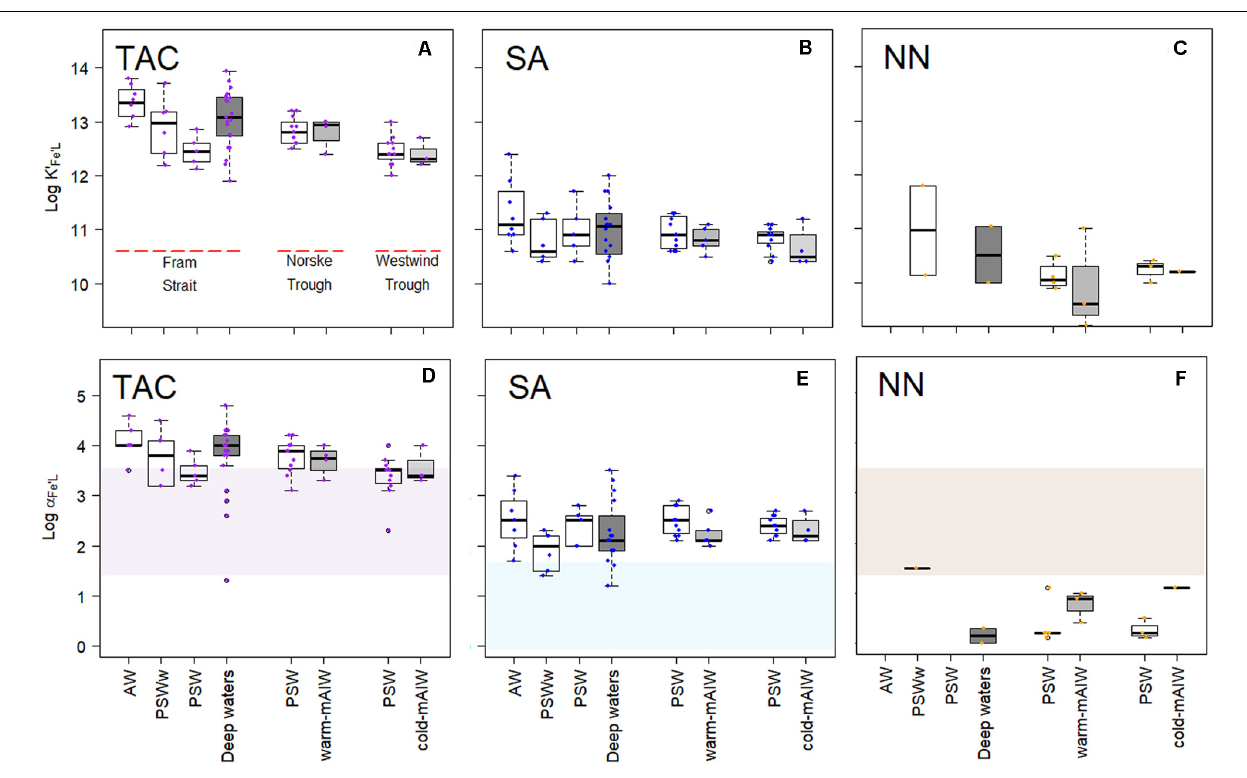
FIGURE 4 | Boxplot of the conditional stability constants (log K (cid:48) Fe (cid:48) L , A–C ) and side reaction coefficients (log α Fe (cid:48) L , d , e , f ) from three different methods using TAC, SA and NN as the AL. The shades in (D–F) indicate the detection window (log Dw) for each method. The details of the boxplot are described in Figure 2